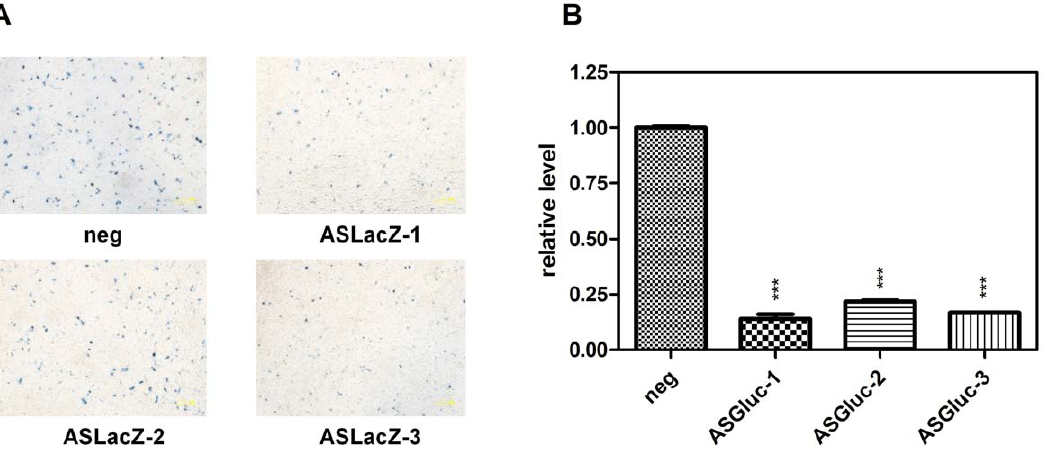
Figure 4. Suppression of two reporter genes by the shRNAs cloned with our methods. (A) HepG2 cells were seeded in 24-well plates and cotransfected with 200 ng of pAAV-LacZ, 200 ng shRNA plasmid and 100 ng pSEAP2-Control (used as a normalization control). LacZ was stained and photographed 48 h after cotransfection of HepG2 cells. Magnification 6 200. The scale bar represents 1 m m. (B) The same procedure described above was carried out using pCMV-Gluc in place of pAAV-LacZ. After 48 h, Gluc activity was determined. An shRNA scaffold (targeted to